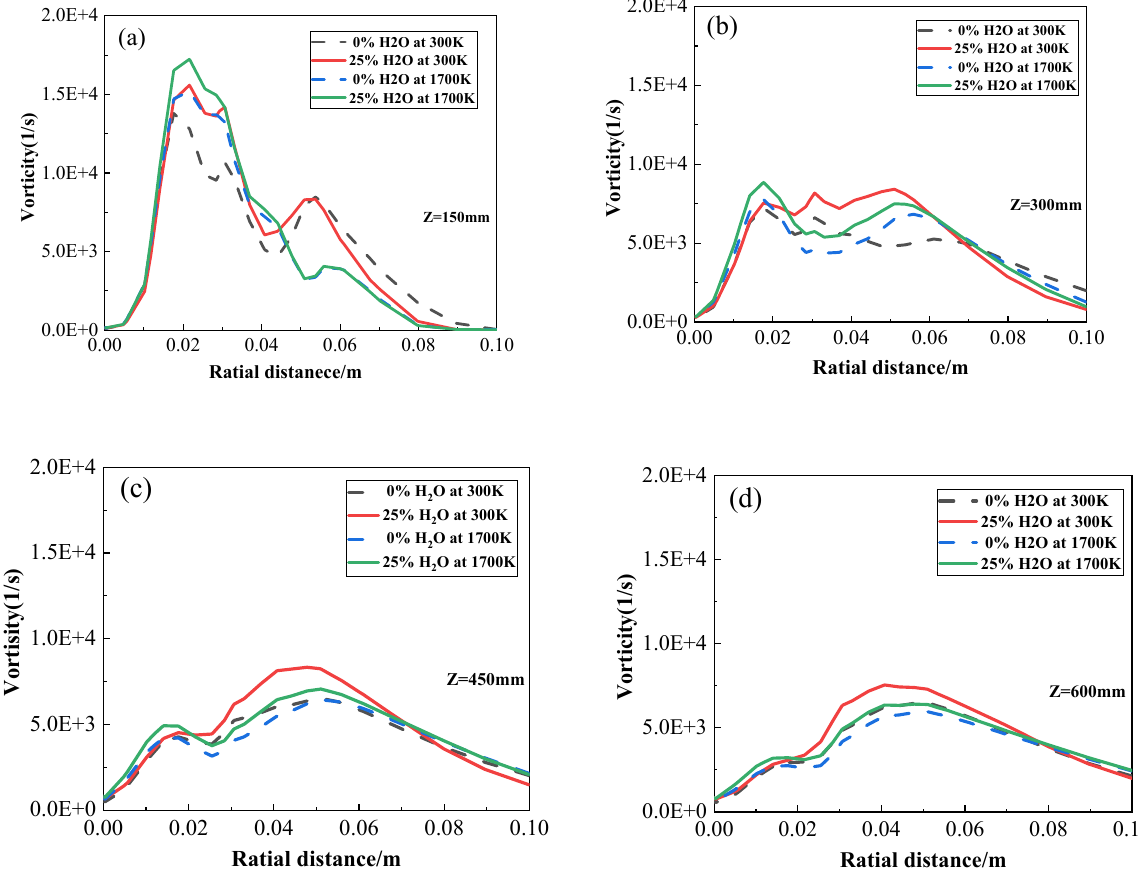
Figure 12. Radial distribution of the jet vorticity at different positions from the jet outlet under ambient temperatures of 300 and 1700 K: ( a ) Z = 150 mm, ( b ) Z = 300 mm, ( c ) Z = 150 mm, and ( d ) Z = 600 mm.